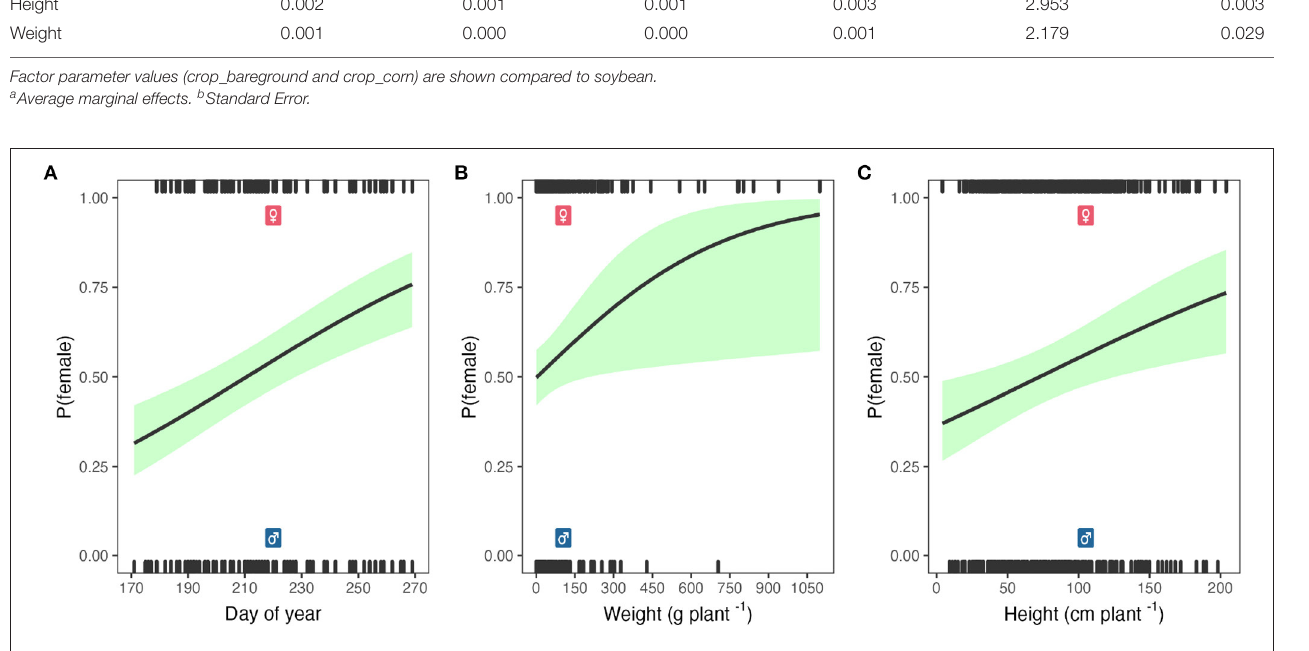
TABLE 2 | Average marginal means of Palmer amaranth sex dimorphism logistic model. Term AME a SE b Lower Upper Z-score P -value Crop_bareground − 0.048 0.054 − 0.154 0.059 − 0.876 0.381 Crop_corn − 0.148 0.052 − 0.250 − 0.046 − 2.842 Doyh 0.004 0.001 Height 0.002 0.001 0.001